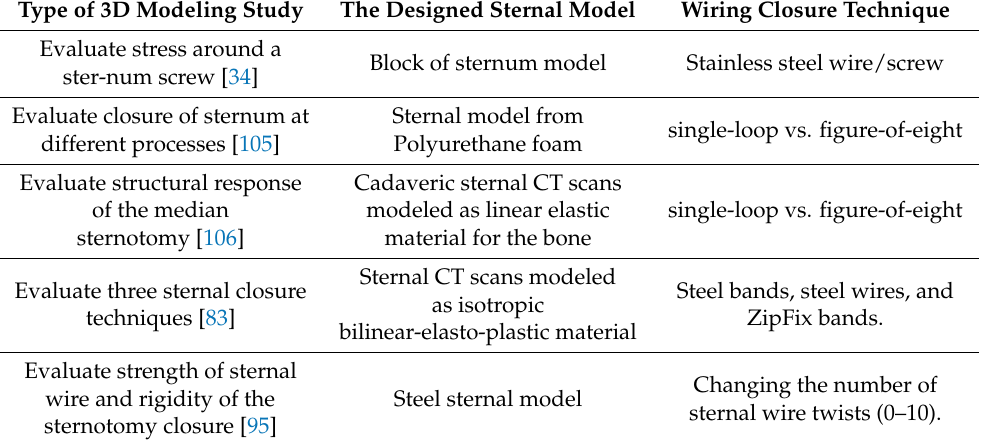
Table 9. Details of reviewed complex sternal fixation